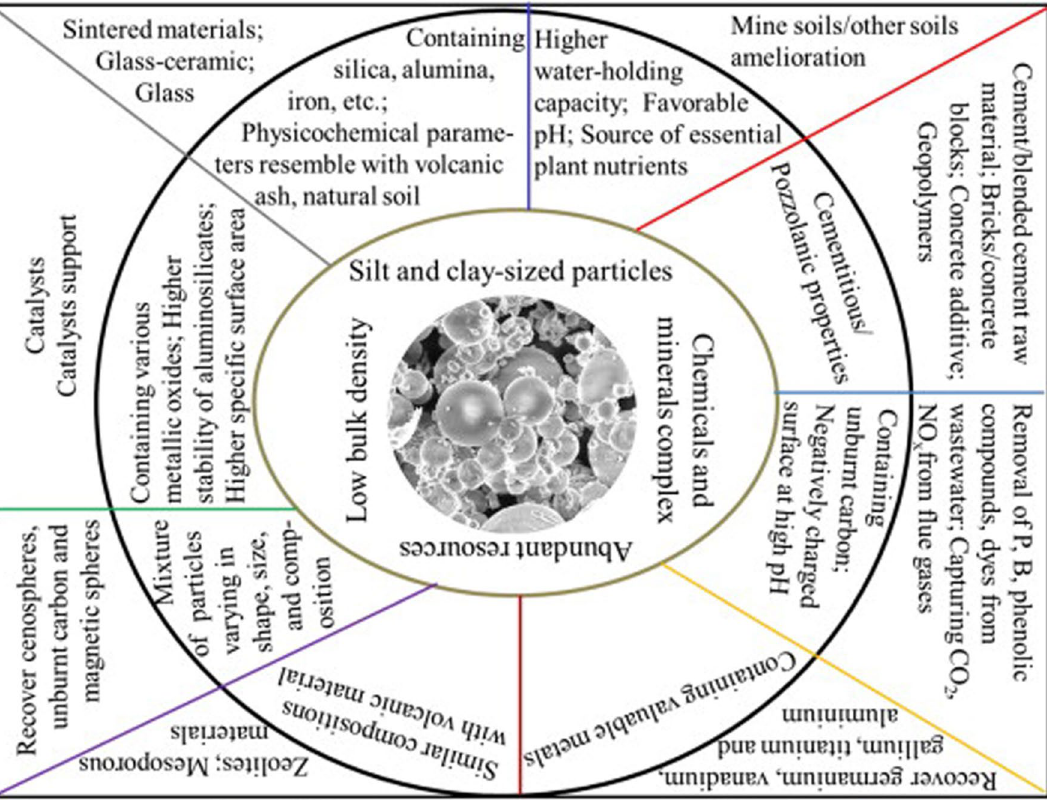
Fig. 2 Applications of CFA (Yao et al.